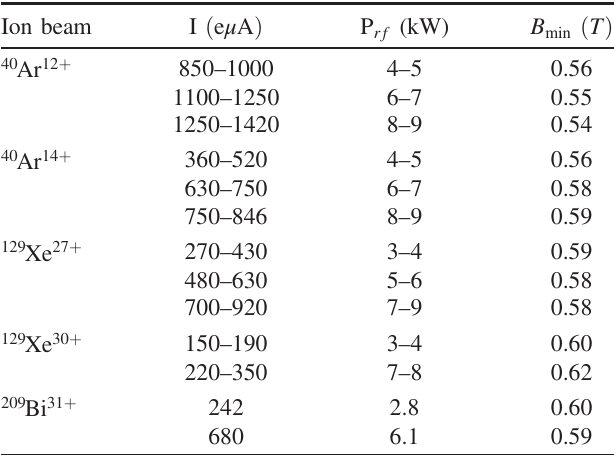
TABLE III. The optimum B values and the corresponding min beam intensities for optimizing different ion beam production at different microwave power level during SECRAL beam tests at 24 þ 18 GHz.